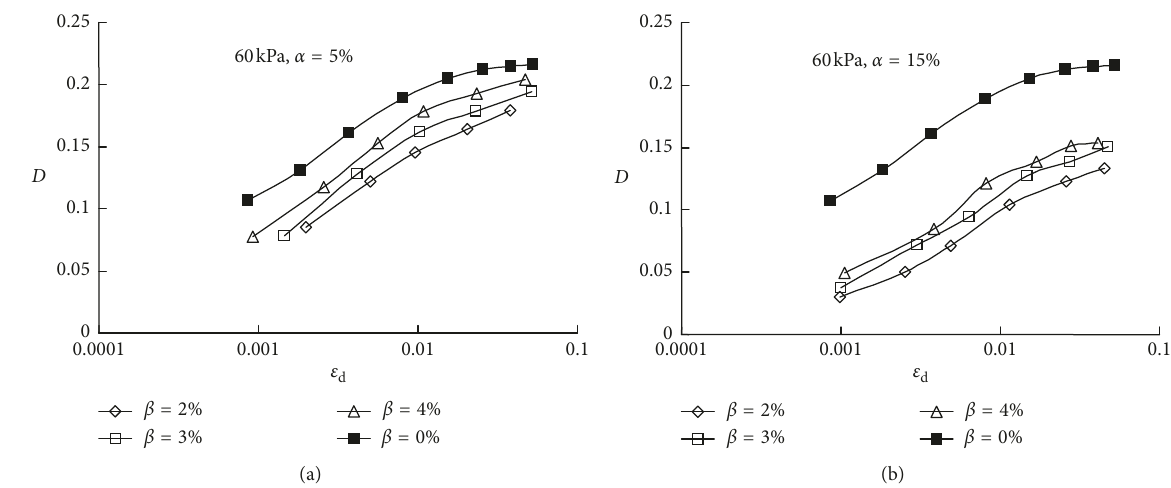
Figure 13: Relationship between the damping ratio and dynamic strain of LCES and clay at different beads